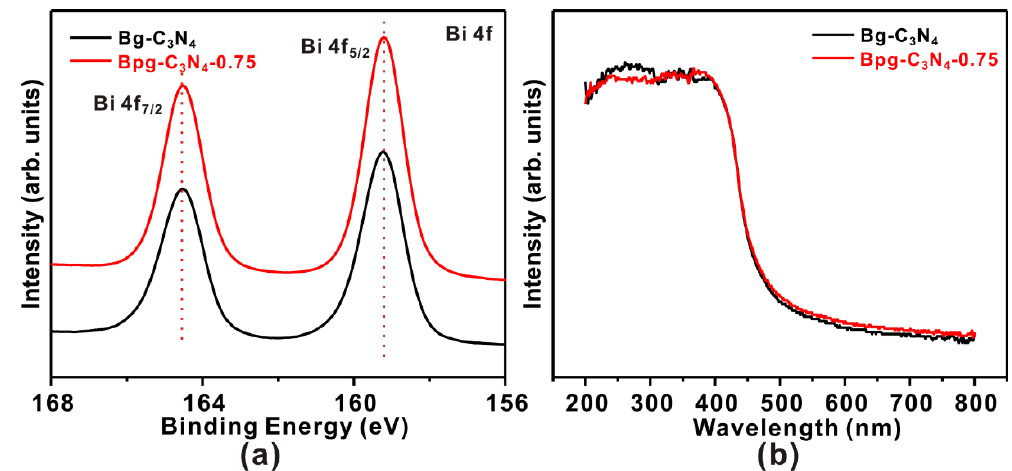
Figure 6. ( a ) Bi 4 f spectra and ( b ) UV-Vis spectra of Bg-C 3 N 4 and Bpg-C 3 N 4 -0.75.